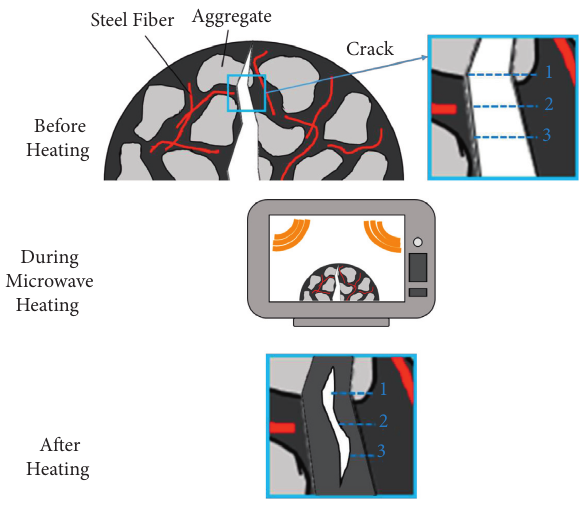
Figure 6: Schematic diagram of crack closure via microwave heating